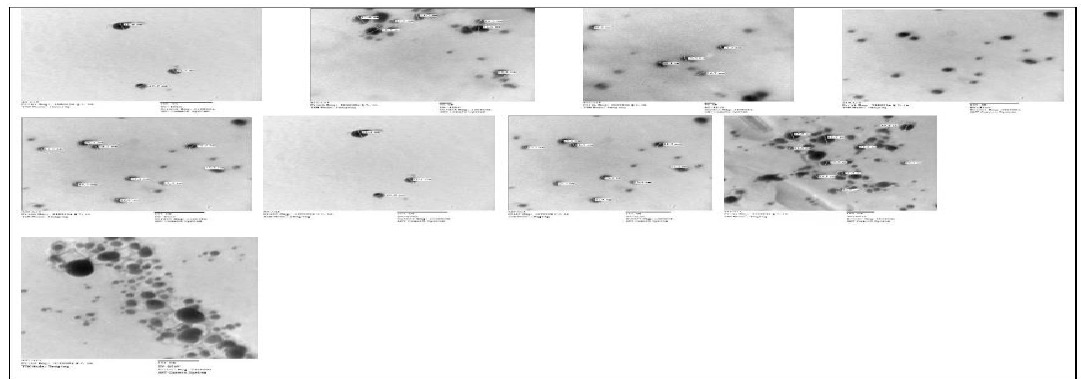
Figure 9. TEM pictures of silver nanoparticles synthesized by Acinetobacter baumannii supernatant.